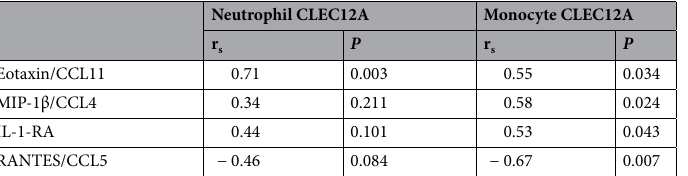
Table 3. Correlations between neutrophil and monocyte CLEC12A expression and cytokine levels at baseline in early RA patients. r s Spearman’s correlation coefficient, P p value, cytokines were analyzed as continuous variables, n = 15.